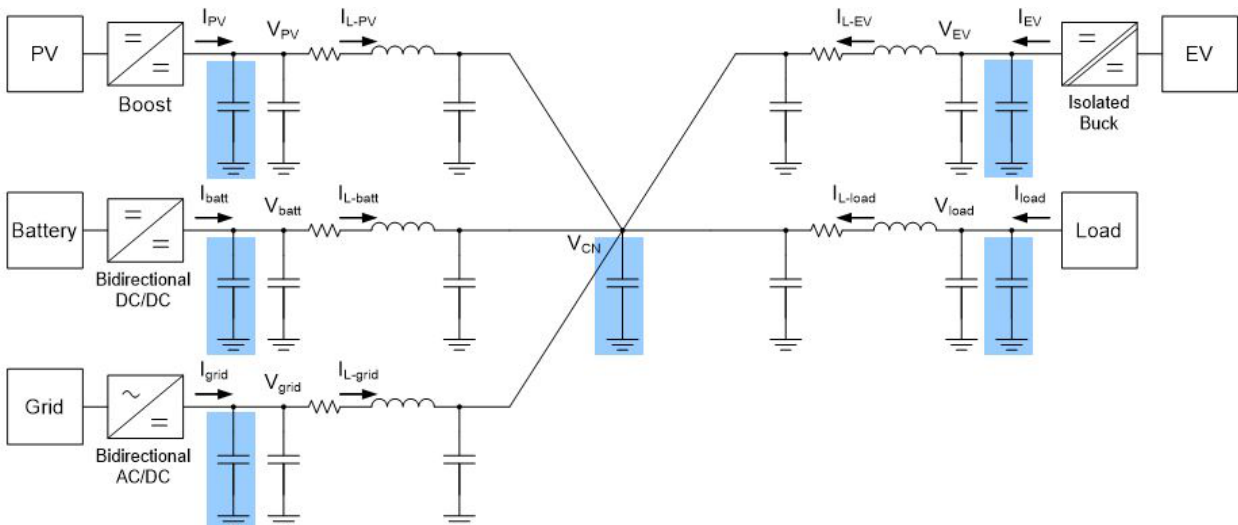
Figure 8. Single line diagram of a DC